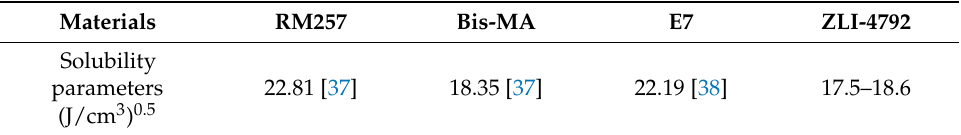
Table 9. Solubility parameters of RM and LC materials used in the experiments.